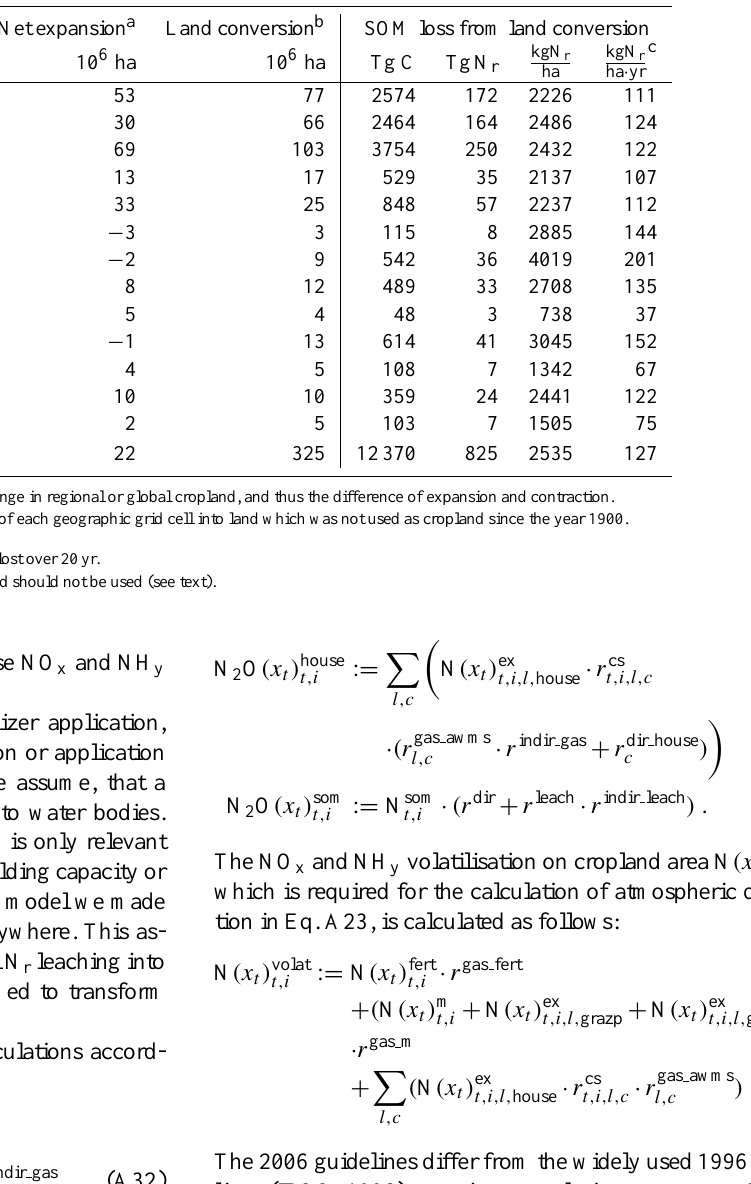
Table A7. Land conversion due to cropland expansion and release of N r from subsequent soil organic matter (SOM) loss. For sources see text. Net expansion a